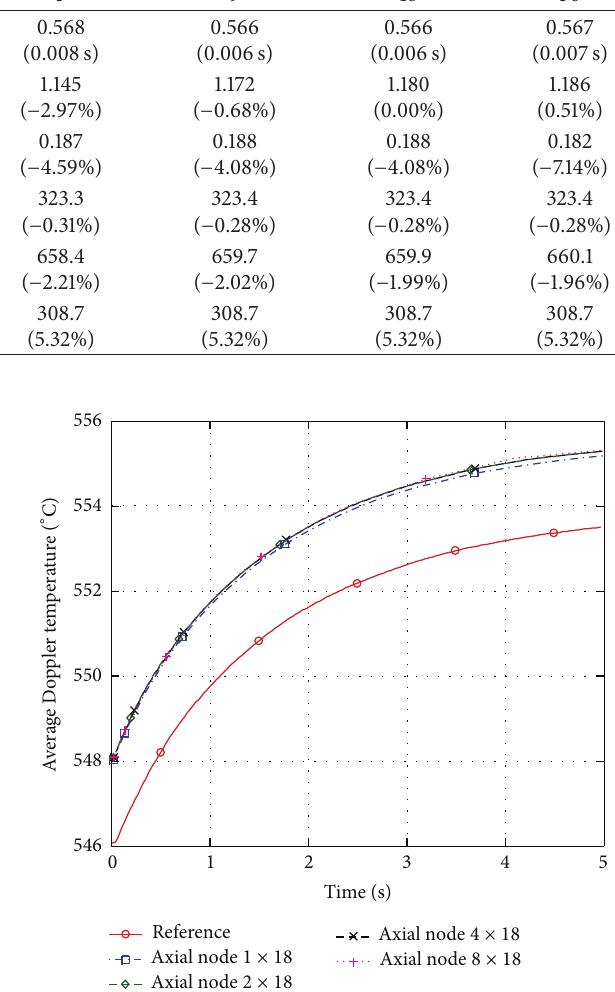
Figure 9: Effect of axial layer size on the average Doppler tempera- ture for case A2.